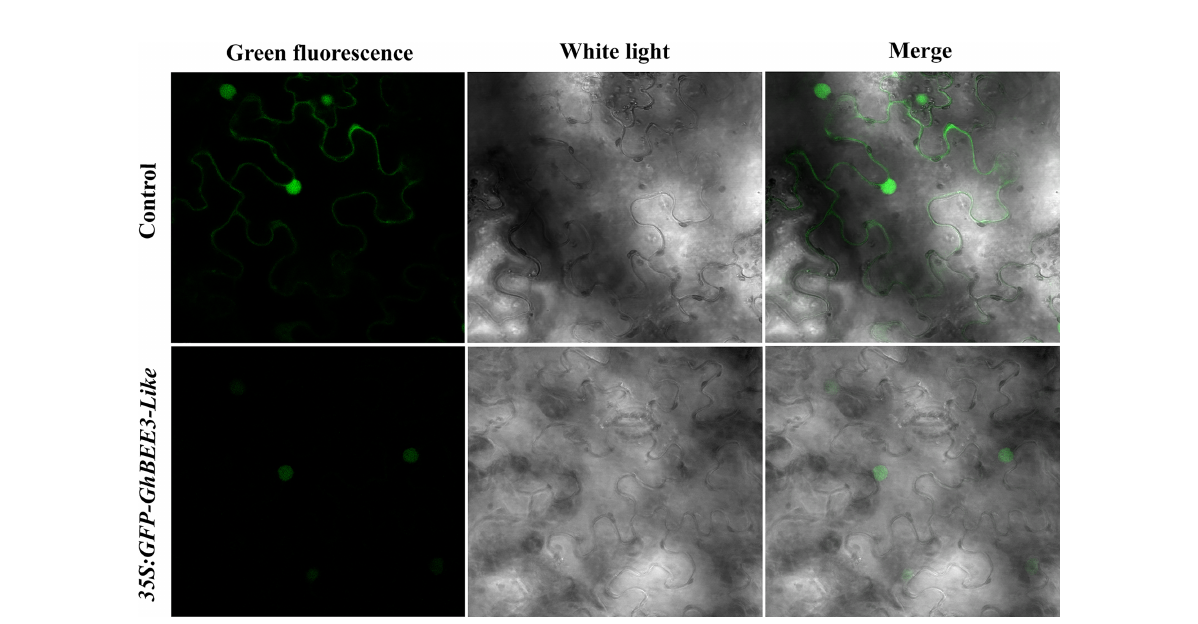
FIGURE 2 GhBEE3-Like protein localization analysis in tobacco mesophyll cells. The three images above indicate the control with free green fl uorescence protein (GFP) signals. GFP-GhBEE3-Like fusion protein signals are shown in the three images below. GFP signals indicated that GhBEE3-Like was localized in the nucleus.